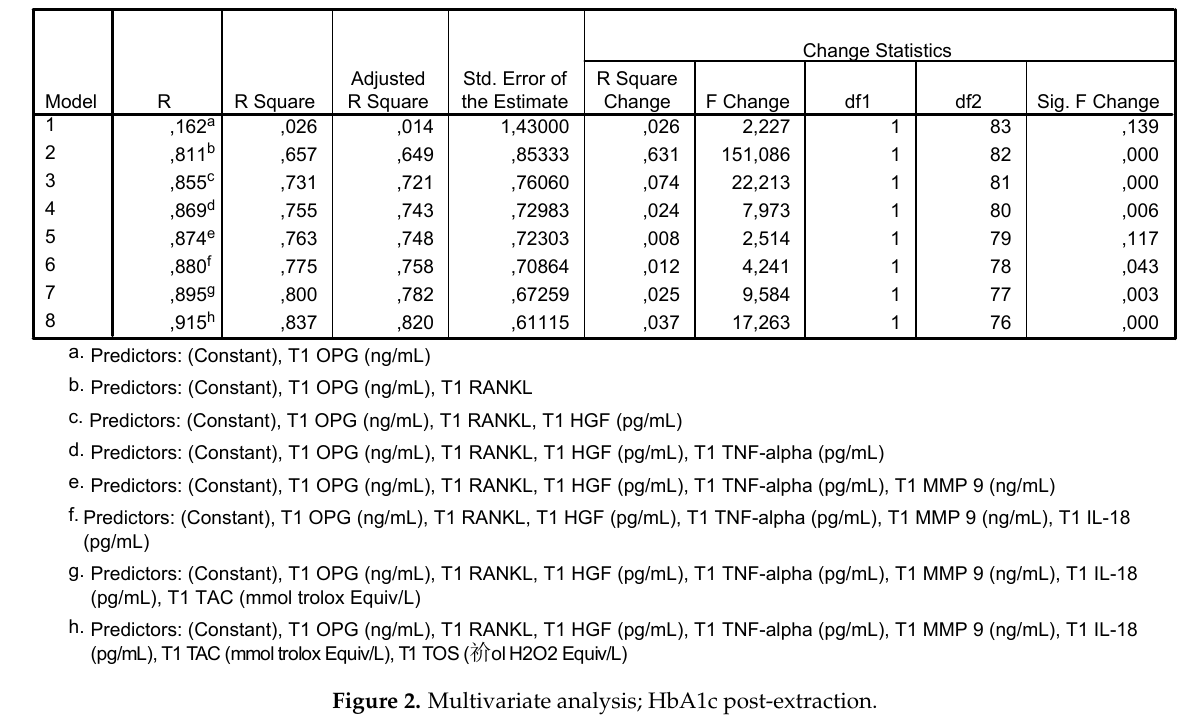
Figure 2. Multivariate analysis; HbA1c post ‐ extraction.